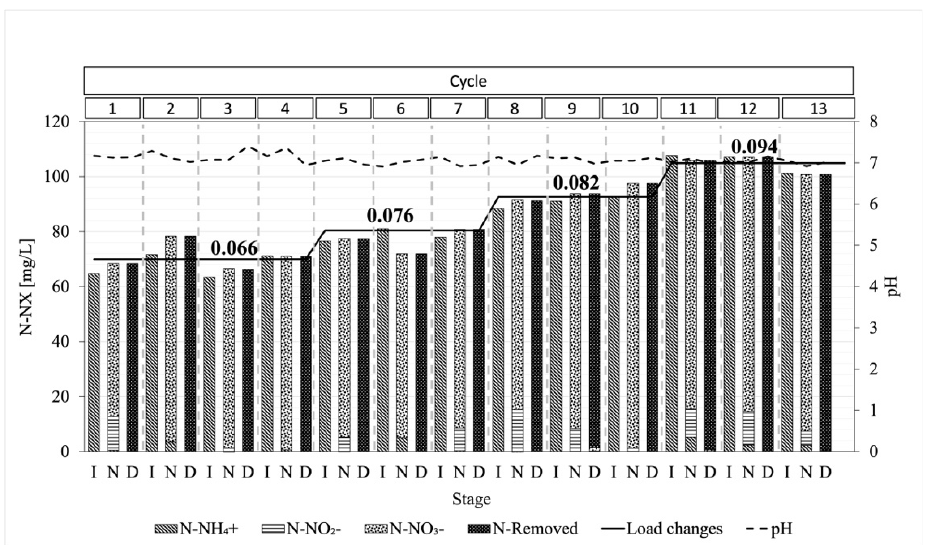
Figure 7. Results of the sequential aDN process. Nitrogen balance R1. Beginning of the cycle (I), end of the nitrification phase and beginning of denitrification (N), and end of denitrification (D). Numbers above black line represent NRL: kg N/(m 3 ·d).